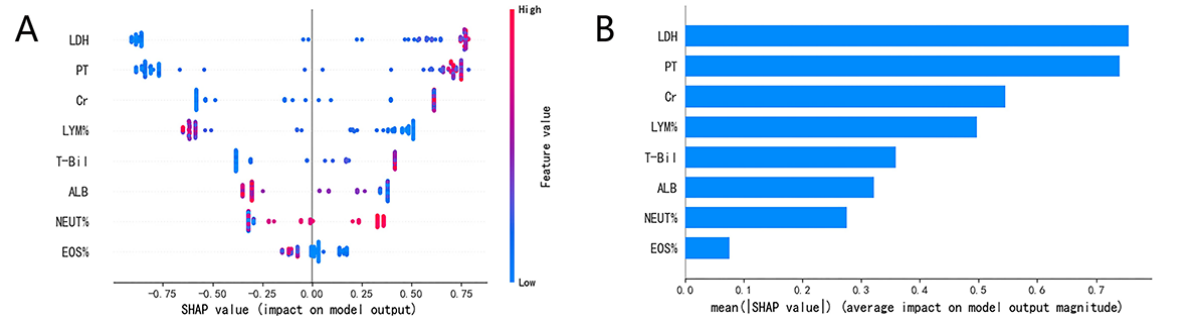
Figure 7. The XGBoost model based on the SHAP algorithm. (A) The attributes of the features in the black box model. Each line represents a feature, and the abscissa is the SHA P value, which represents the degree of influence on the outcome. Each dot represents a sample. The redder the color, the greater the value of the feature, and the bluer the color, the lower the value. (B) Ranking of feature importance indicated by SHAP. ALB: albumin level; Cr: creatinine; EOS%: eosinophil percentage; LDH: lactate dehydrogenase; LYM%: lymphocyte percentage; NEUT%: neutrophil percentage; PT: prothrombin time; SHAP: SHapley Additive exPlanations; T-Bil: total